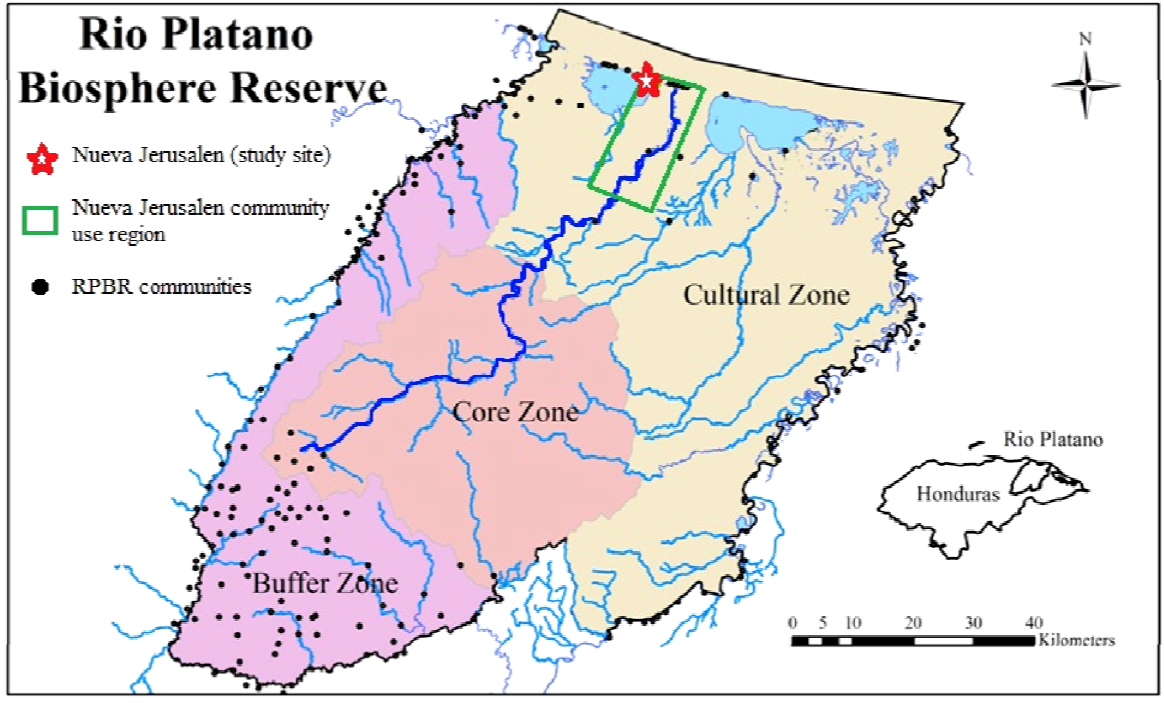
Figure 1. Map of the study area within the boundary the Rio Plátano Biosphere Reserve of Gracias A Dios,